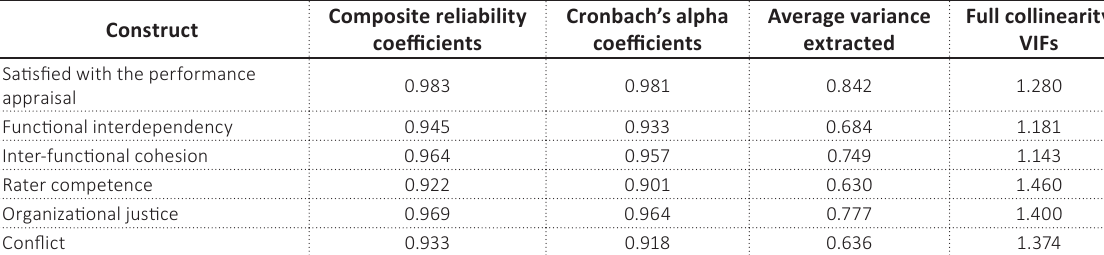
Table 2. Results of reliability